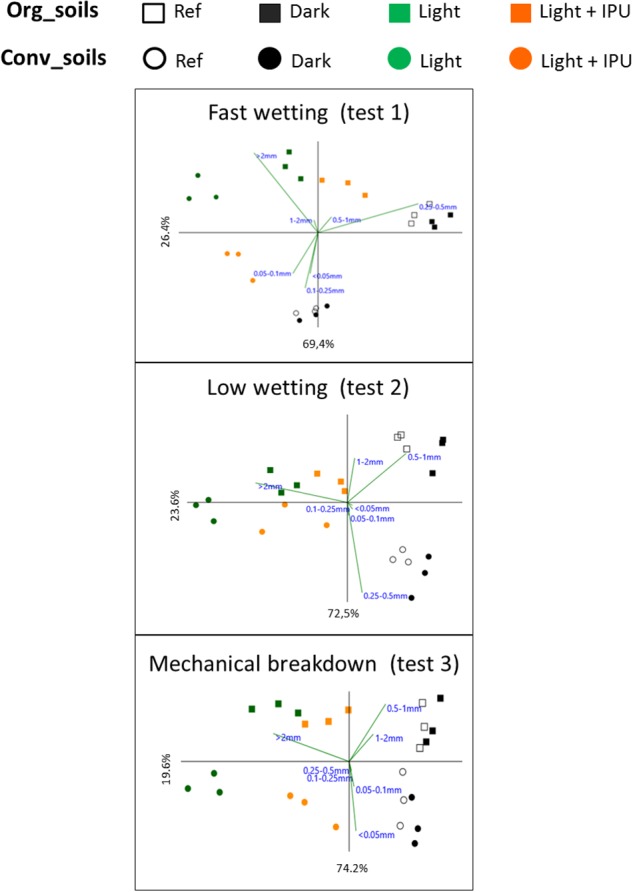
Principal component analyses of the class size distribution, following each stability tests, of the soil aggregates from Organic (filled squares) or Conventional (filled circles) cropping systems, at the end of microcosm incubations (day 50) under the different conditions (Dark, Light, Light + IPU, see Table 1 for acronym description). Reference soil aggregates (Ref, at day 0) are shown by open symbols. The biplot (vectors lengths) shows the contribution of each class size to the difference among groups.